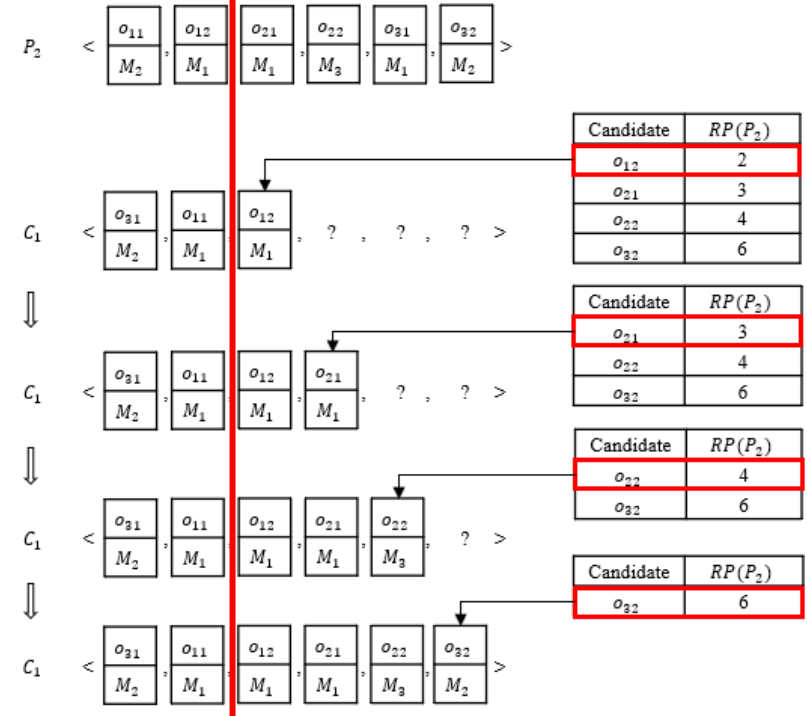
Figure 5. Generating the later part of the offspring